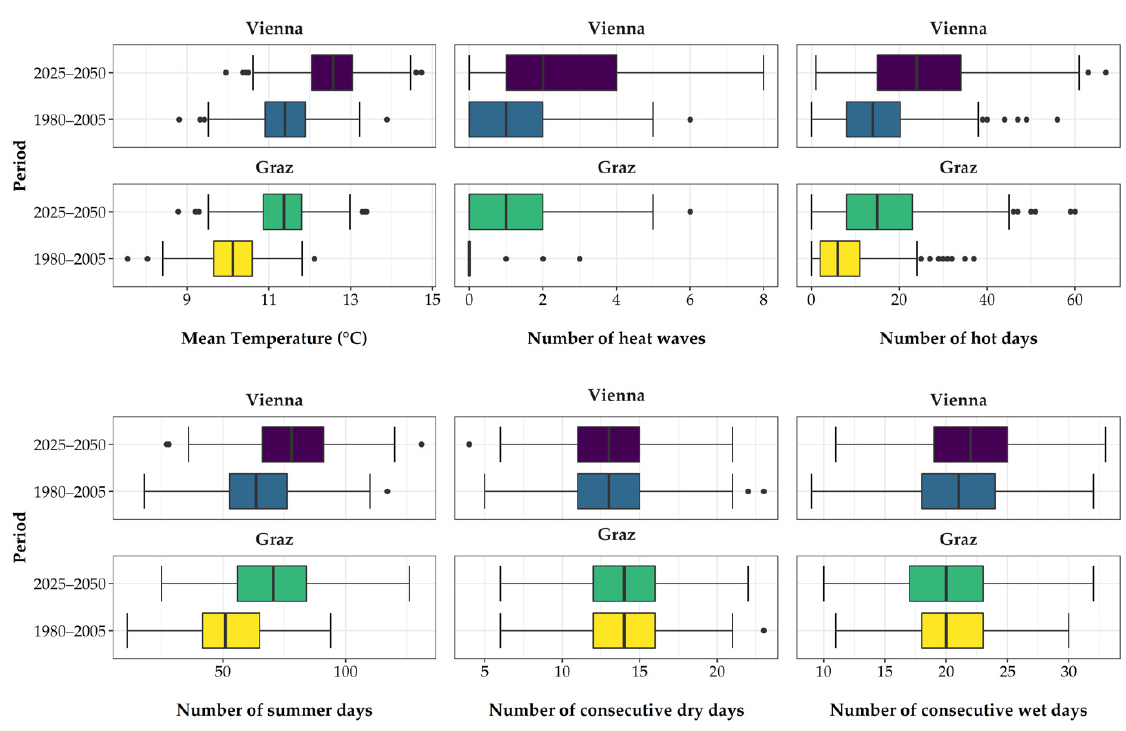
Figure 5. Comparison of the climate indices for the time period 2025–2050 with the reference period 1980–2005 for Graz and Vienna. In this figure the bandwidth of climate indices is shown resulting from 16 different climate projections.